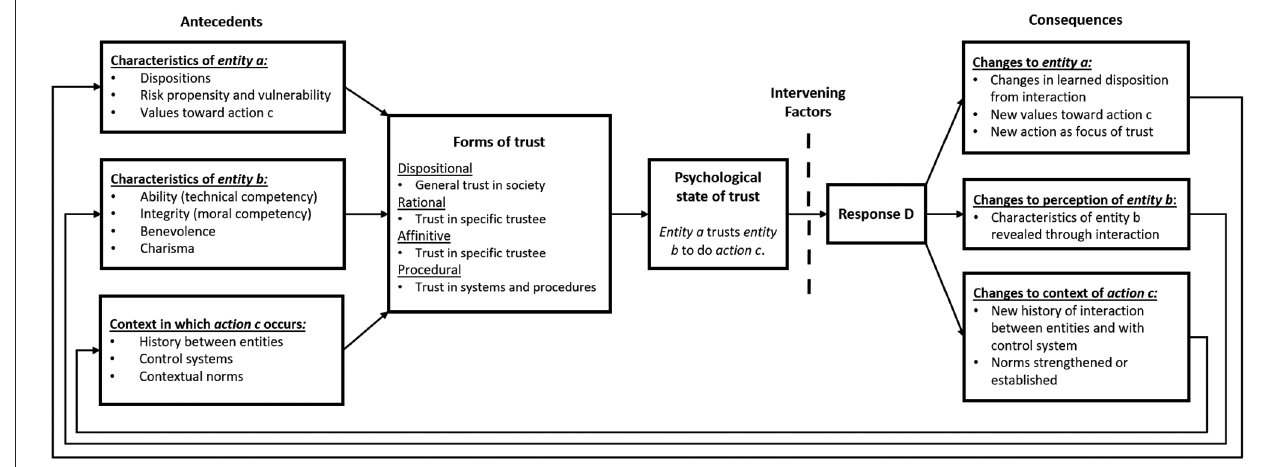
FIGURE 1 | Framework illustrating key components of trust theory (adapted from Stern and Coleman,